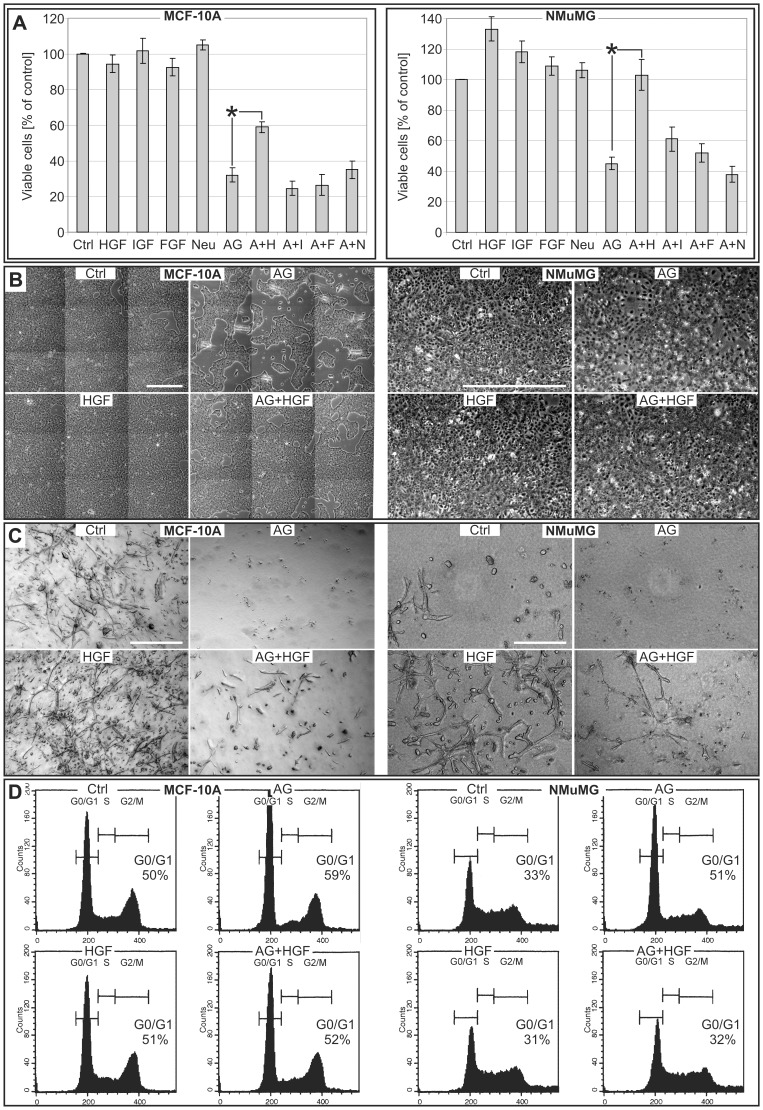
HGF act as a recovery agent in EGFR inhibited mammary epithelial cells. A.Viable cell count by trypan-blue exclusion staining at 48 h of MCF-10A (left panel) and NMuMG (right panel) cells cultivated in their respective growth medium and treated with the indicated factors (HGF 10 ng/ml (H), IGF-I 100 ng/ml (I), b-FGF 20 ng/ml (F), Neuregulin 20 ng/ml (N); AG1478 250 nM (A)). Untreated control (Ctrl) was set to 100%. Columns, mean (n = 6); bars, S.E.M. *P<0.05. B. MCF-10A cells (left panels; composite of 9 fields) and NMuMG cells (right panels) cultivated in their respective growth medium for 24 h with the indicated factors (HGF 10 ng/ml; AG1478 250 nM). Bar  = 1000 µm. C. Extended death of field composite image obtained from multiple Z-stacking pictures of MCF-10A cells (left panels) and NMuMG cells (right panels) grown in collagen for 4 days with the indicated factors (HGF 10 ng/ml; AG1478 250 nM). Bar  = 500 µm. D. Cell cycle distribution examined by propidium iodide staining and FACS analysis of MCF-10A cells (left panels; 8 h) and NMuMG cells (right panels; 16 h) cultivated in growth medium and treated with the indicated factors (HGF 10 ng/ml, AG1478 250 nM).